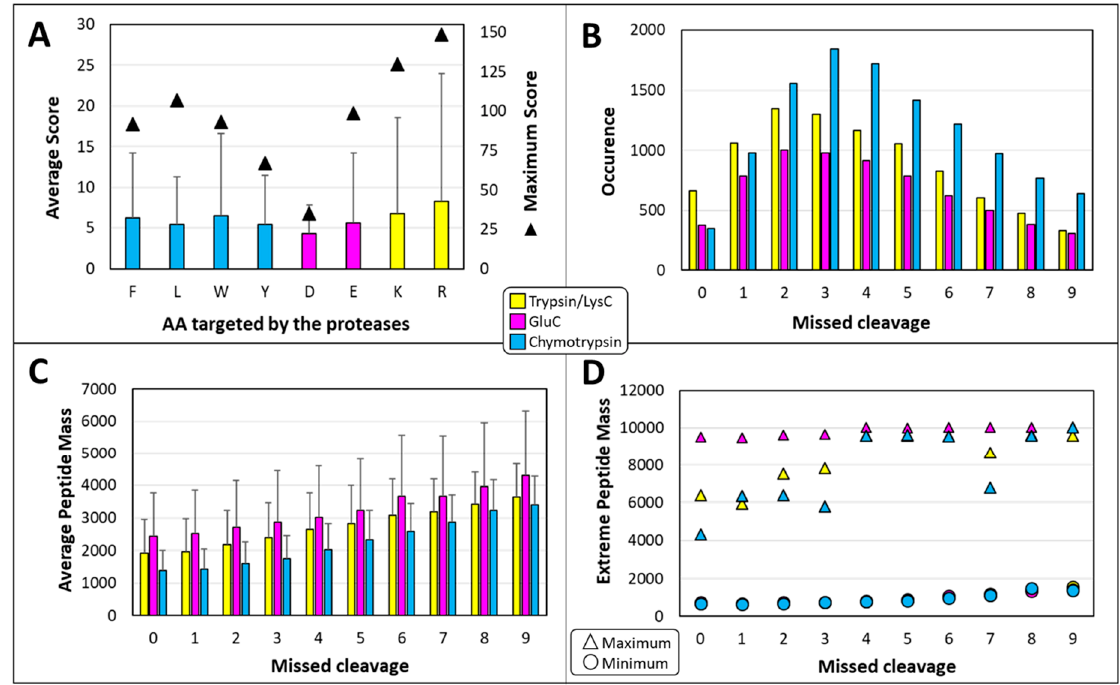
Figure 4. Statistics on medicinal cannabis peptides. ( A ) Averaged peptide ion score per AA residue targeted by the proteases. Maximum are represented by triangles. Vertical bars denote SDs. ( B ) Distribution of the numbers of missed cleavages per protease. ( C ) Distribution of the average masses of the cannabis peptides according to the number of missed cleavages. Vertical bars denote SDs. ( D ) Minimum (circles) and maximum (triangles) masses of the peptides according to the number of missed cleavages.